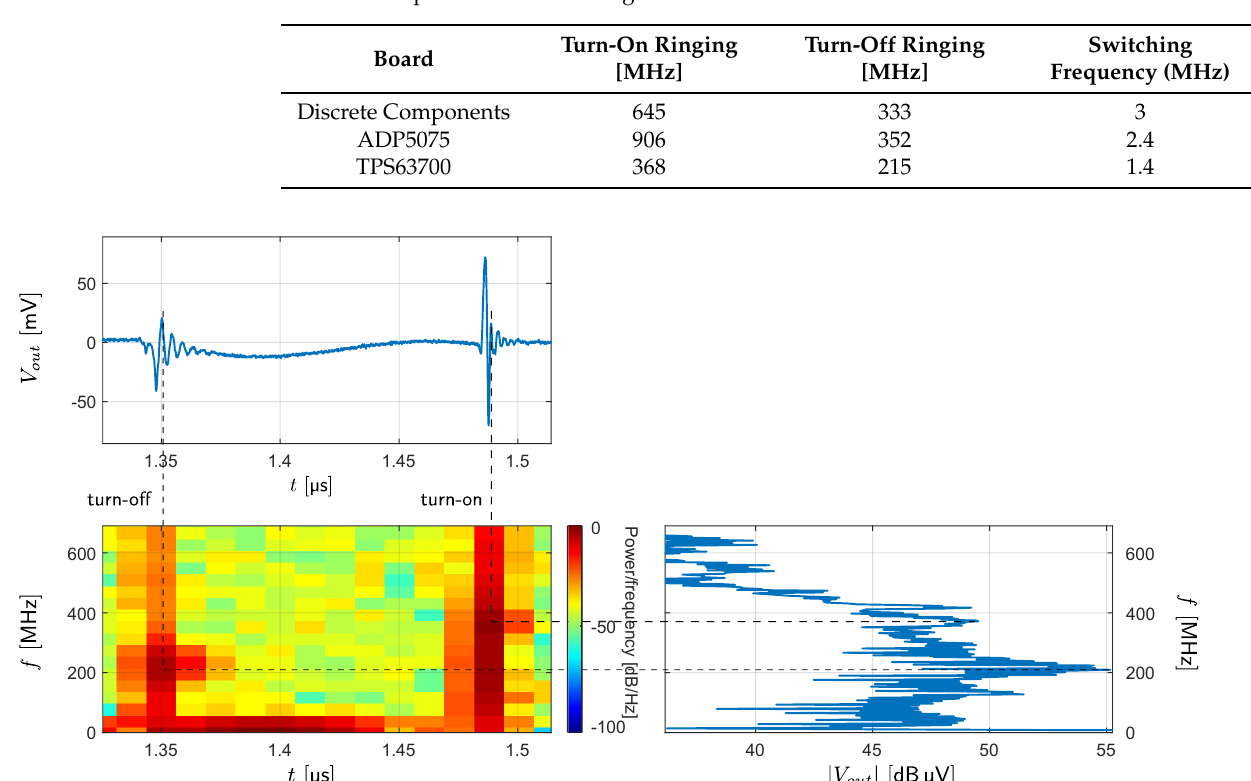
Table 3. Comparison of the investigated converters.